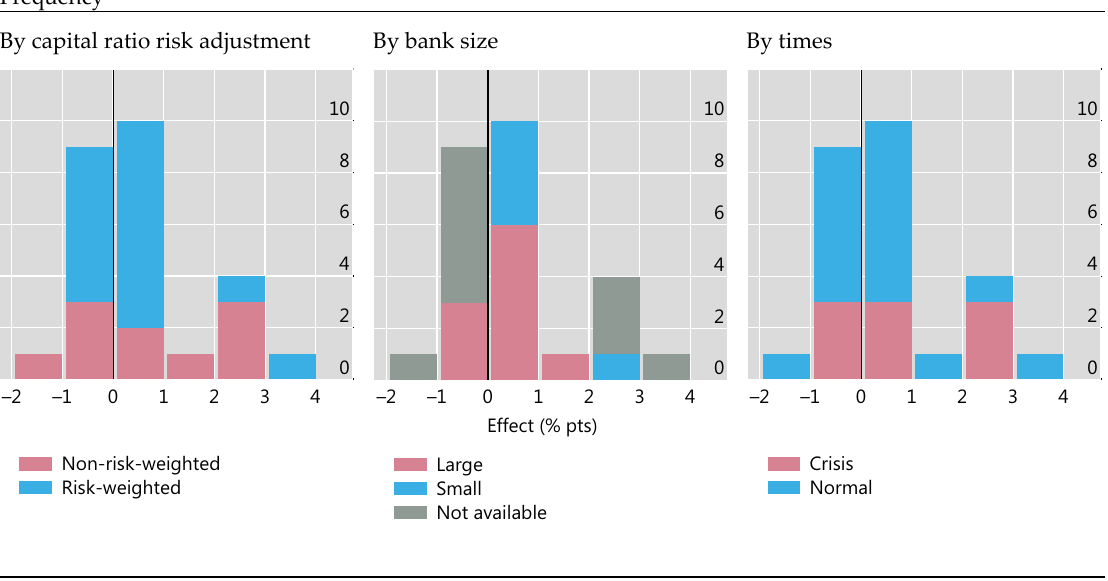
Figure 5. Effect of a one percentage point higher capital ratio on the short term growth of bank lending (literature). Based on 26 estimates from 13 studies (see references Aiyar et al. (2014a), Aiyar et al. (2014b), Aiyar et al. (2016), Behn et al. (2016), Bernanke et al. (1991), Berrospide and Edge (2010), Bridges et al. (2014), Dell’Arriccia et al. (2017), Gambacorta and Shin (2018), Iyer et al. (2014), Kapan and Miniou (2018), Kim and Sohn (2017), Roulet (2018)).